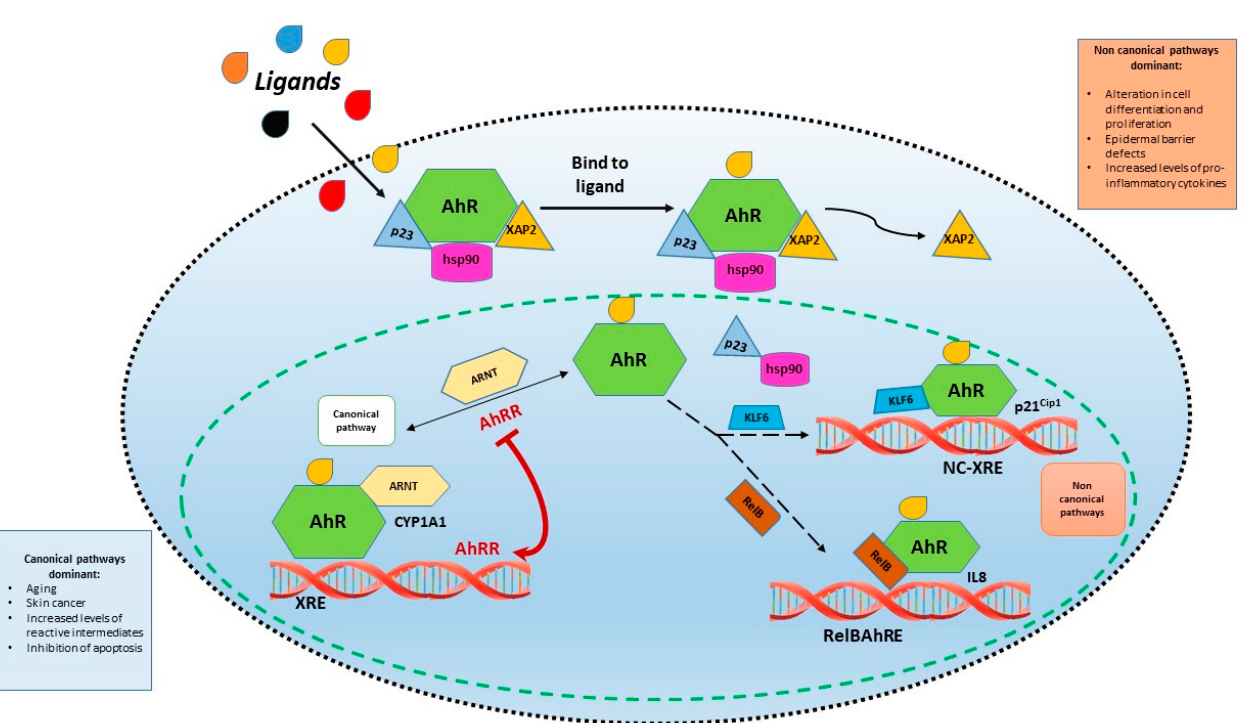
Figure 1. Canonical and non-canonical signaling pathways activated by AhR. In canonical pathways upon ligand-binding by either exogenous or endogenous agonists, AhR undergoes conformational changes leading to the dissociation of p23 and XAP2 with consequent translocation in the nucleus and formation of a AhR:ARNT heterodimer. The AhR:ARNT complex binds to upstream regulatory regions of its target genes which contain canonical aryl hydrocarbon XRE elements. In non-canonical pathway ligand-AhR complex can interact directly with sites distinct from the consensus XRE.